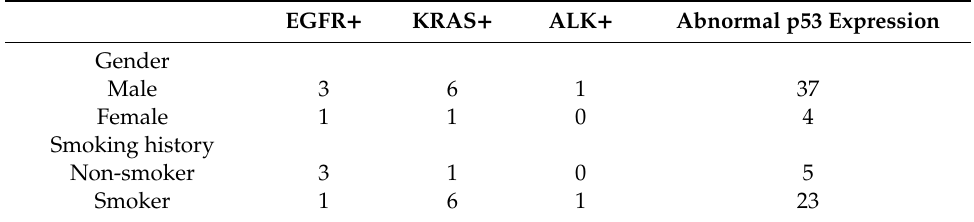
Table 6. Genetic alteration in relation to gender and the smoking history of patients with LAD ( n =